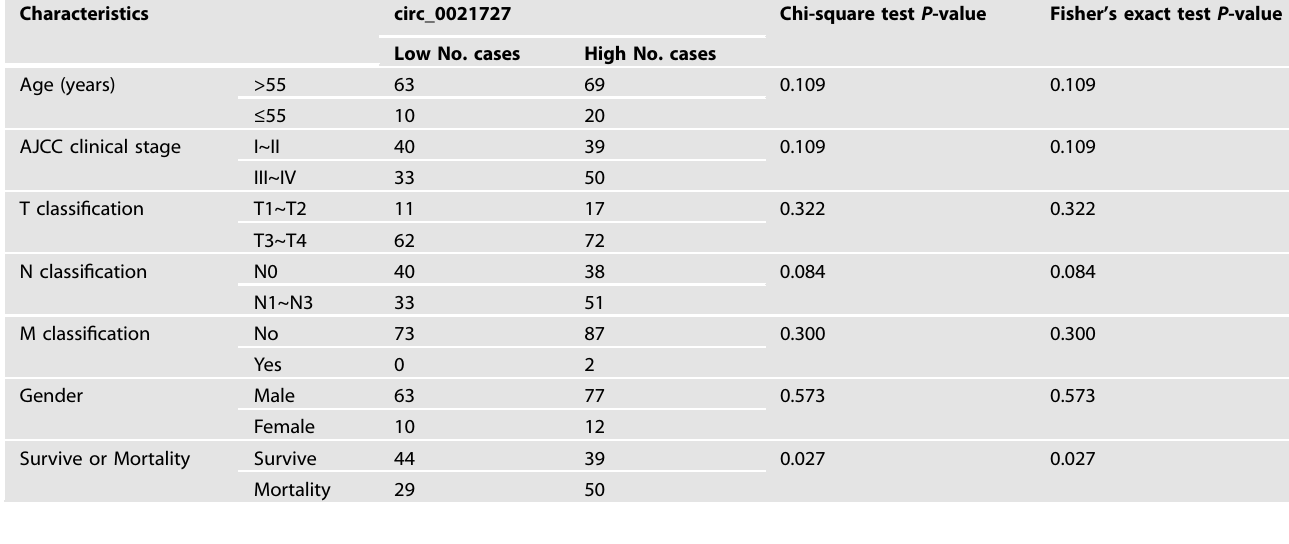
Table 1. Correlation between circ_0021727 expression and clinicopathological characteristics of esophageal cancer. Characteristics